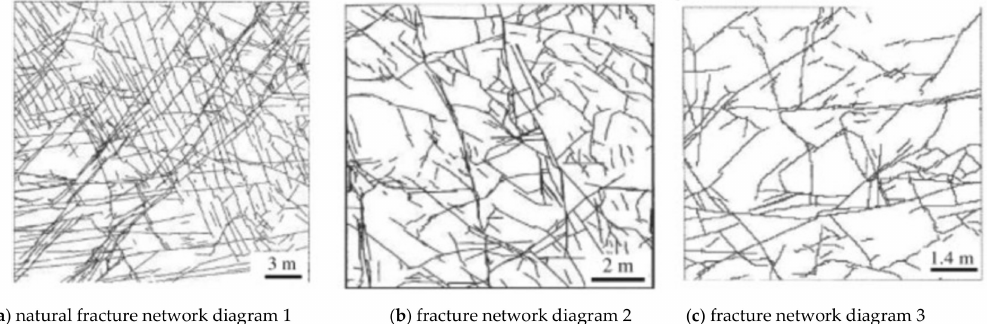
Figure 5. Three rock fracture network diagrams (Reprinted from Figure 11 of reference [28]. Journal of Petroleum Science and Engineering, 92 , Alireza Jafari and Tayfun Babadagli, Estimation of equivalent